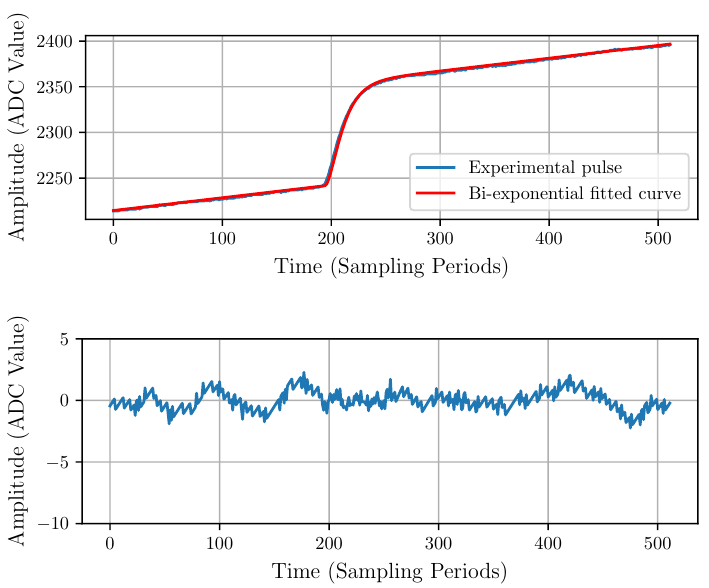
Figure 8. Bi-exponential model fitting ( top ) and corresponding residuals ( bottom ).